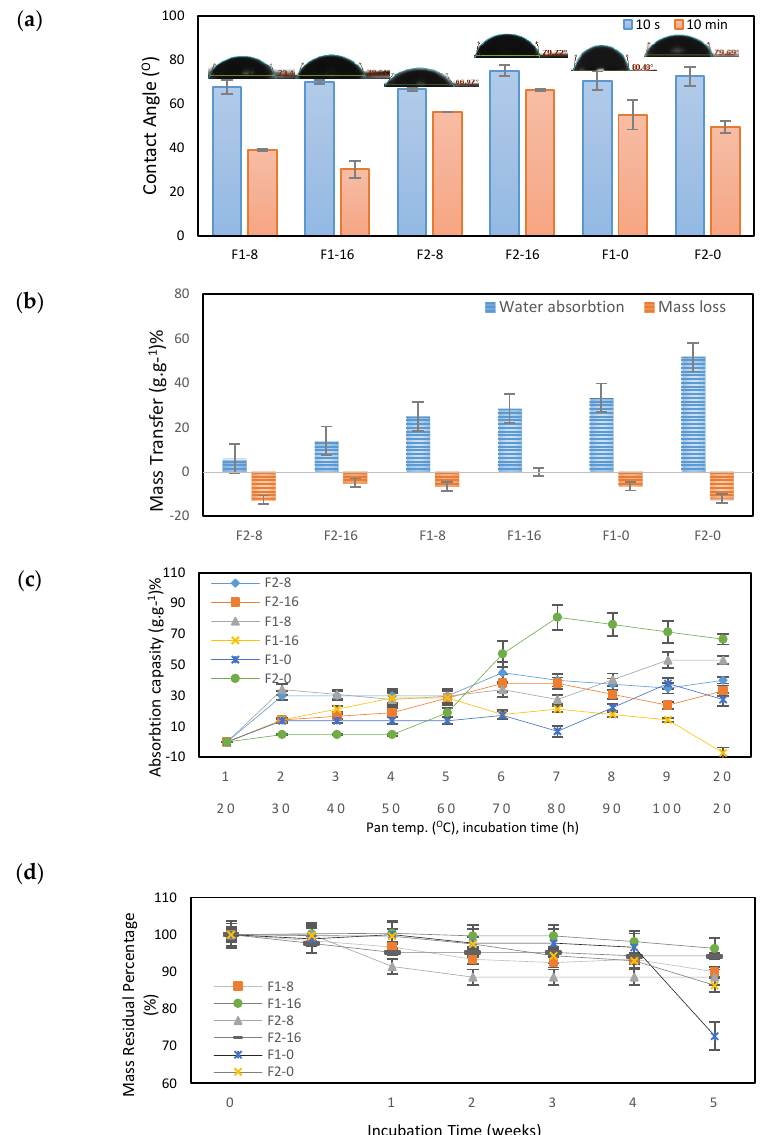
Figure 8. ( a ) The water contact angle vs. time after 10 s and 10 min; ( b ) water absorption (hydration degree) and mass loss after incubation time of 12 h at room temperature; ( c ) Water absorption capacity of the samples as a function of temperature in percentage; and, ( d ) Mass residual percentage vs. incubation time (week).